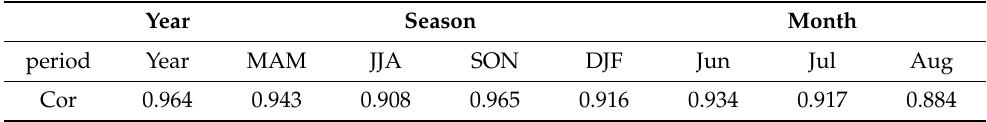
Figure 8. Difference between nighttime precipitation in ( a ) annual average, ( b ) June-July-August (JJA) average, ( c ) March-April-May (MAM) average, ( d ) June average, ( e ) September-October-November (SON) average, ( f ) July average, ( g ) December-January-Februrary (DJF) average, and ( h ) August average from 2010 to 2019 and from 2001 to 2010 (mm/month). Table 2. Spatial correlation coefficients between nighttime precipitation differences and precipitation differences among the two decades in different time